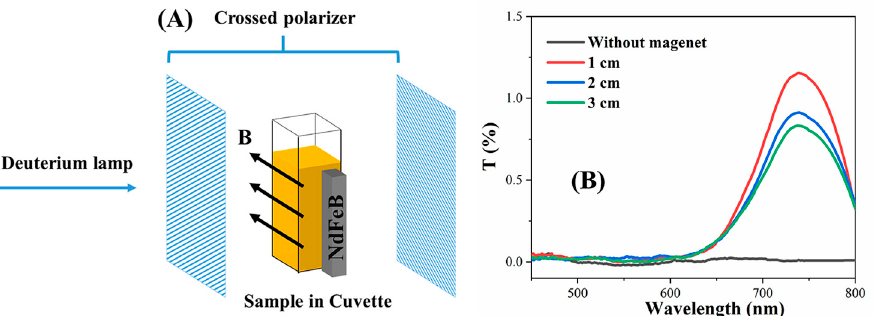
Figure 13. ( A ) The experimental setup for measuring light transmittance using the spectrophotom- eter; ( B ) Transmittance of light through two orthogonal polarizers and GO@Fe 3 O 4 sol at various magnetic field intensities. (The B shows the direction of the magnetic field).